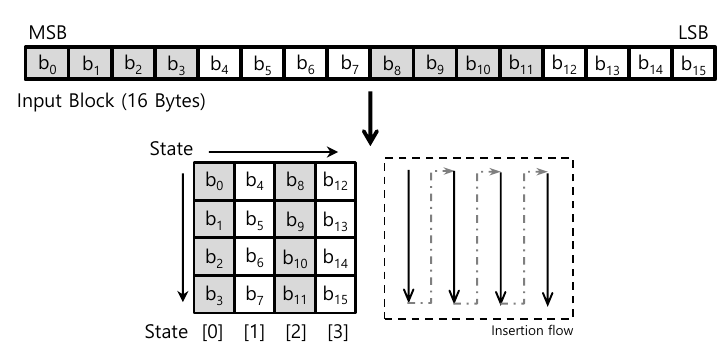
Figure 1: AES Block-to-State Transformation